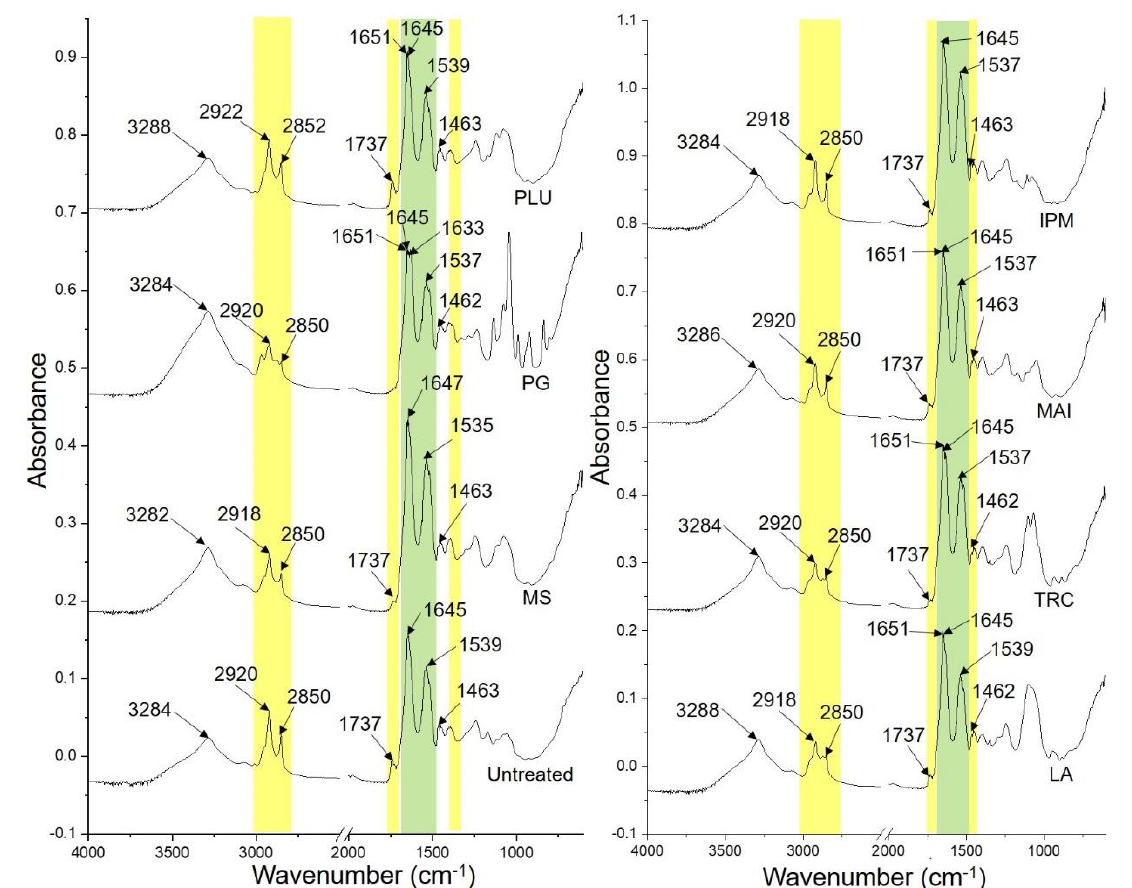
Figure 1. Comparisons of ATR − FTIR spectra of untreated porcine SC sheets and those treated with MS and solvents, with modifications highlighted in the lipid regions (yellow bar) and protein regions (green bars). MS: methyl salicylate; PG: propylene glycol; PLU: Plurol ® oleique CC 497; LA: Labrasol ® ; TRC: Transcutol ® P; MAI: Maisine ® CC; IPM: isopropyl myristate. Table 2. FTIR spectral assignments of porcine SC sheets treated with MS and